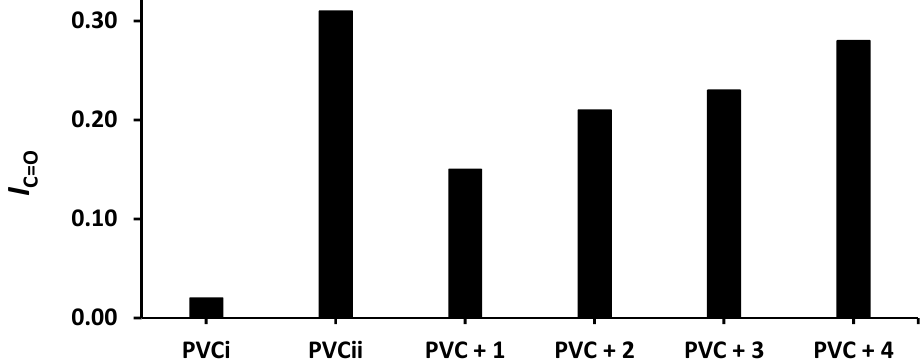
Figure 5. Effect of irradiation (300 h) on the index of the C=O group ( I C=O ) of PVC films containing tin(IV) compounds 1 – 4 . PVC i and PVC ii are the I OH of the blank PVC film before and after irradiation, respectively.